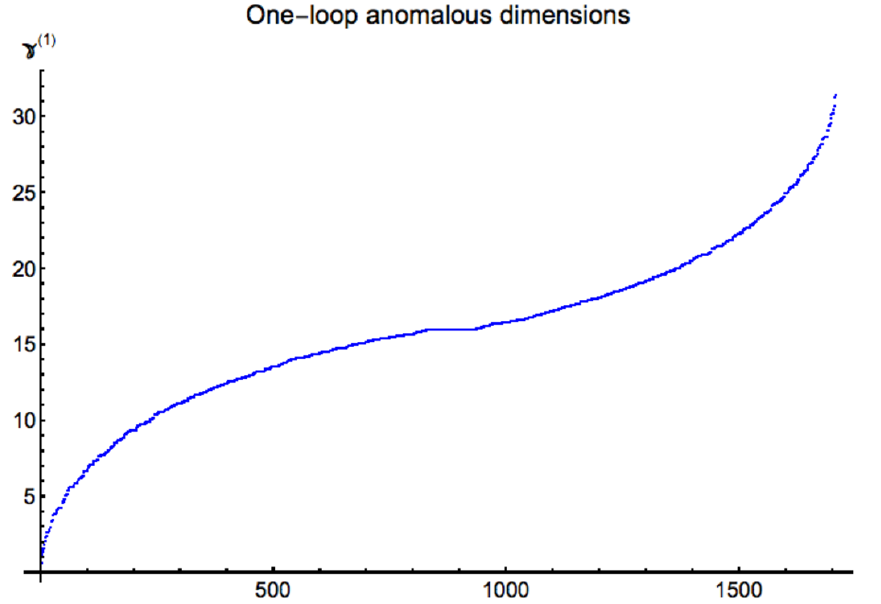
Figure 14 . A ListPlot of the anomalous dimensions (cid:13) (1) of the 1708 so (6) super-primaries in the Super-Class (cid:1) 0 = 24 ; s = 0 ; n = 10 ; m = 10 . The (cid:13)at region in the middle corresponds to 90 f g degenerate super-primaries with anomalous dimension (cid:13) (1) = 16. This degeneracy is (partially) lifted when considering the higher-conserved